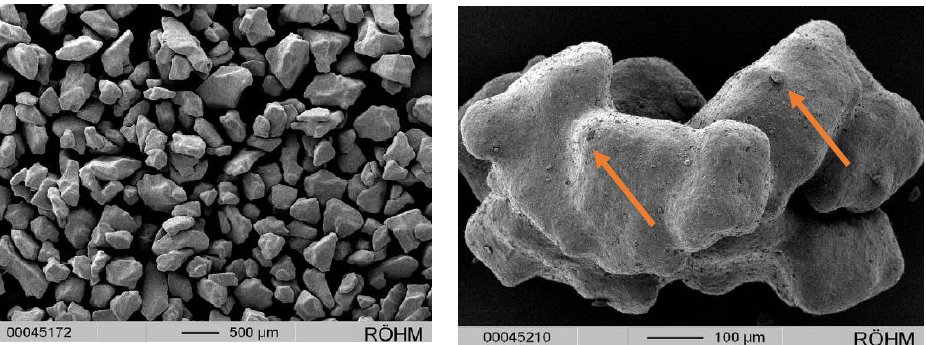
Figure 1. Ritonavir particle shape and small ritonavir particles embedded in eudragit coating. (Orange arrows point to the ritonavir particles).